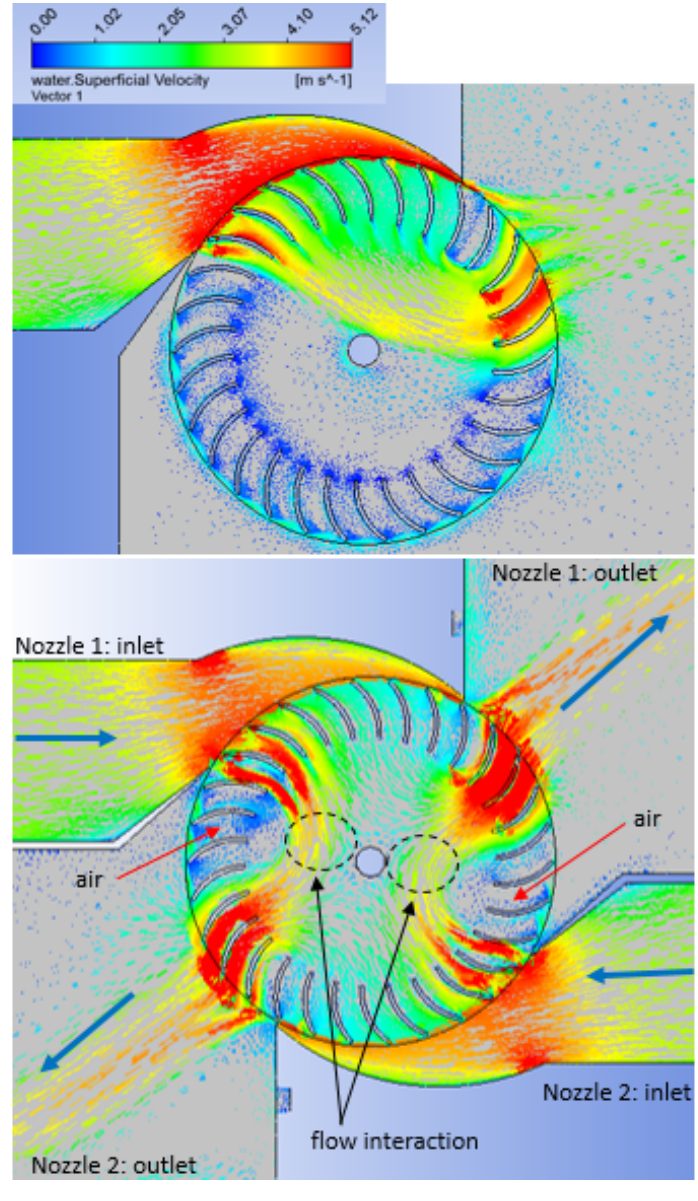
Figure 8. Contours of mean water velocity vectors with a single-nozzle ( a ) and double-nozzle ( b ) operations at maximum efficiency [ Q max = 46 lps per nozzle, H = 1.33 m and ω max = 199